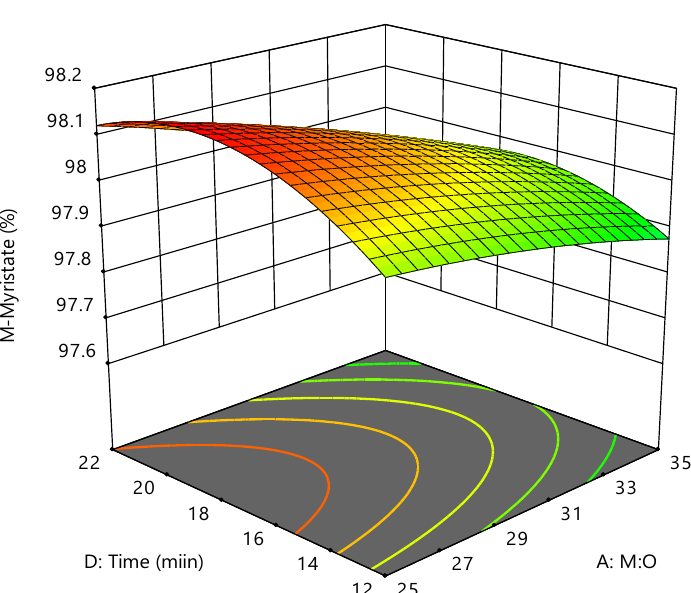
Figure A6. Response surface for the effect of M:O molar ratio and reaction time on the yield of methyl-myristate.